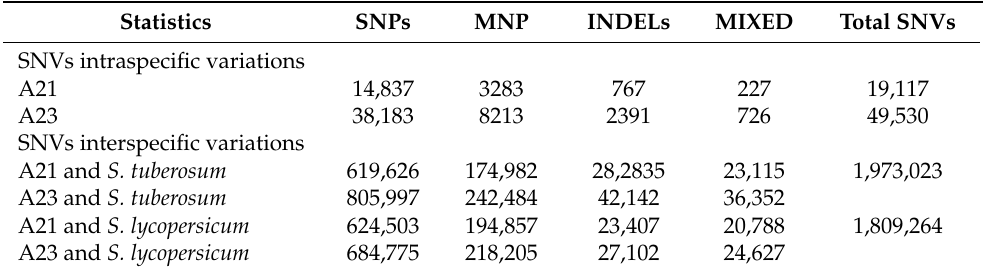
Table 3. Polymorphism statistics for the tree tomato A21 and A23 transcriptomes. Statistics